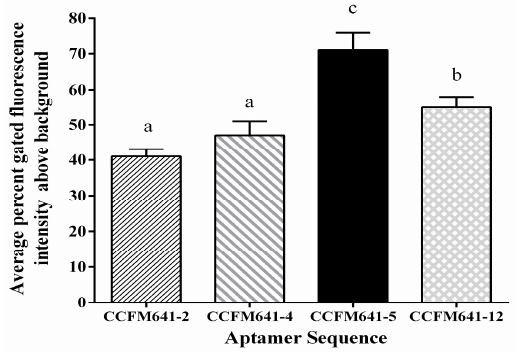
Figure 1. Binding affinity of aptamers for B. bifidum . The 5 ′ -FAM-labeled individual aptamers were incubated with B. bifidum at 37 °C for 45 min (as described in the text). The values of aptamer binding represent the mean ± SD of three independent experiments. Bars with different letters are significantly different ( p < 0.05).